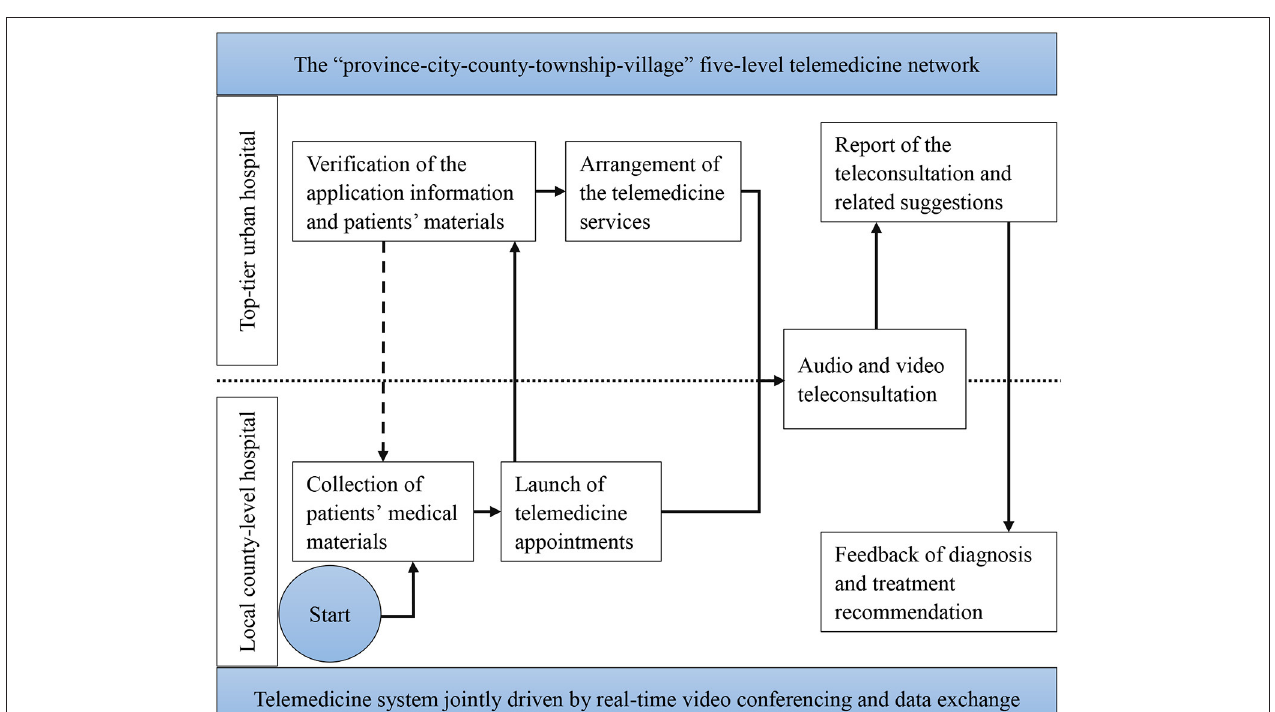
FIGURE 4 | The general operation procedure of telemedicine services in